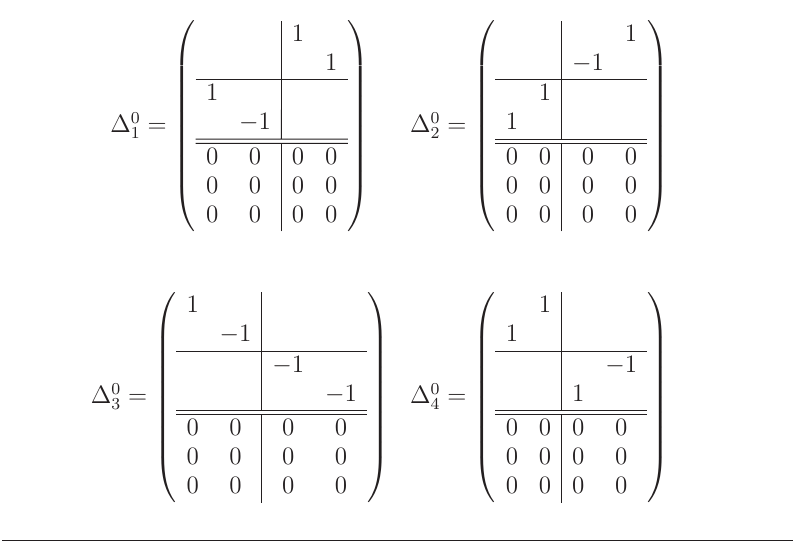
Table 7: The time-like down matrices associated with the Maxwell field-strength multiplet.